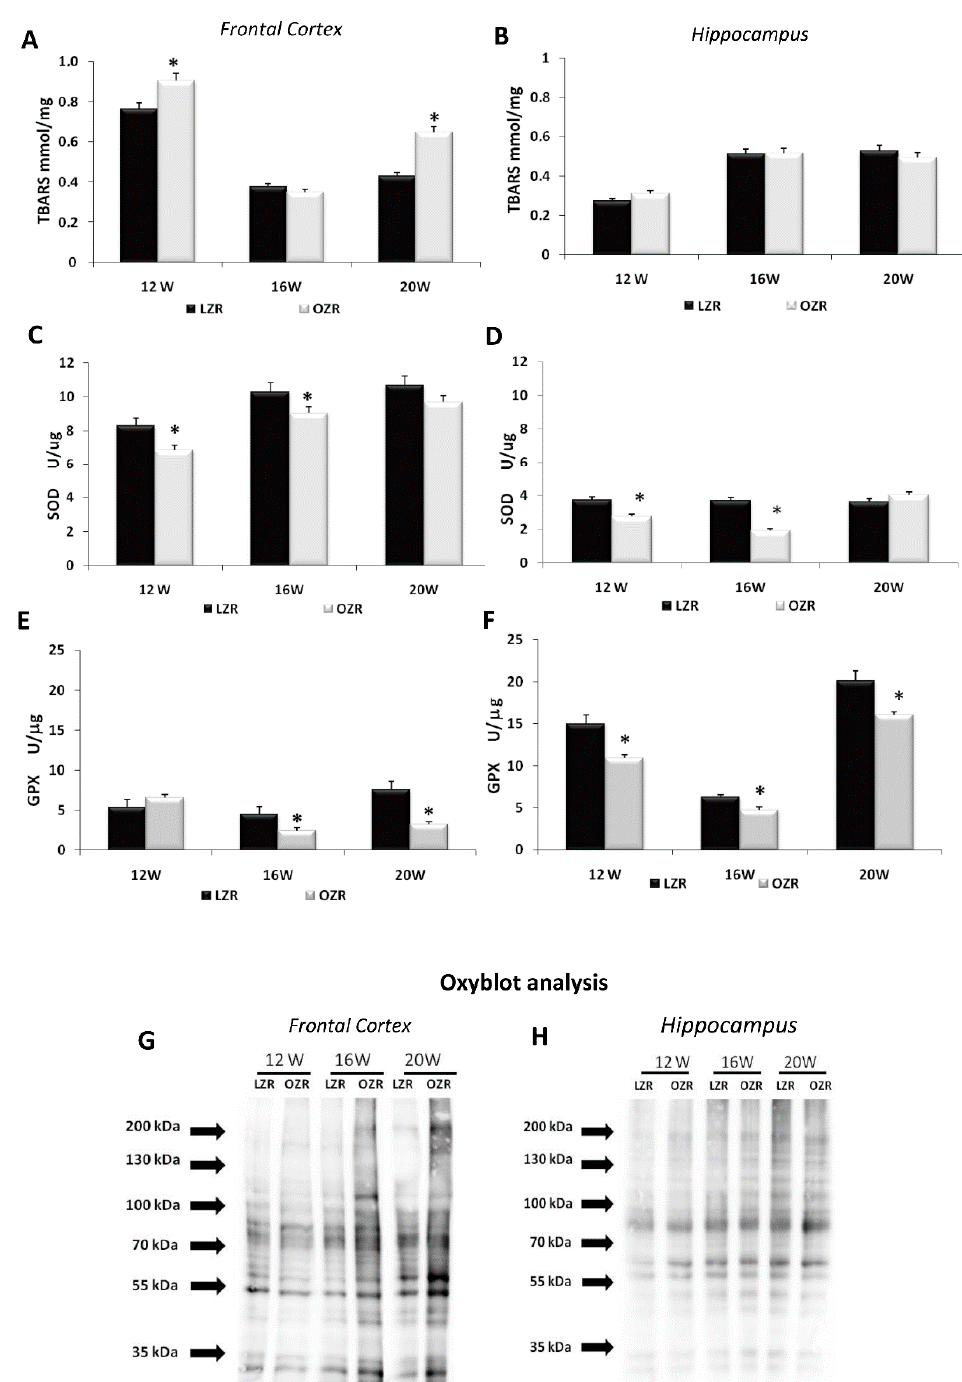
Figure 2. Oxidative stress parameters in the frontal cortex ( A , C , E , G ) and hippocampus ( B , D , F , H ) for LZRs and OZRs of 12-, 16-, and 20-weeks age. The data of thiobarbituric acid reactive substances TBARS level (expressed in mmol / mg of tissue) ( A , B ), superoxide dismutase activity SOD (expressed as U / µ g of proteins where one unit is the amount of enzyme needed to exhibit 50% dismutation of the superoxide radical) ( C , D ), and glutathione peroxidase activity GPX (expressed U / µ g where one unit define as the amount of enzyme that will cause the oxidation of 1.0 nmol of NADPH to NADP + per minute at 25 ◦ C) ( E , F ). Data are the mean + SEM. * p < 0.05 vs. age-matched LZRs. The two inferior panels represent the results of Oxyblot of proteins extracted from the frontal cortex ( G ) and hippocampus ( H